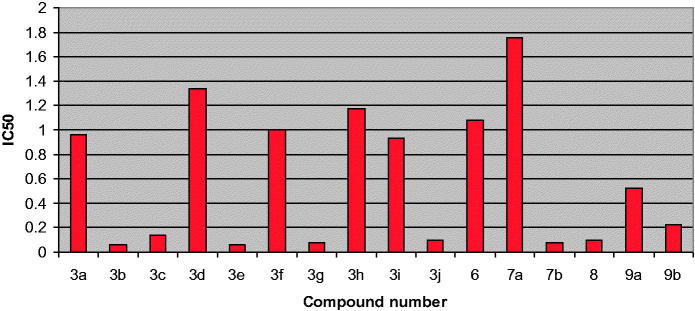
IC50 of the synthesised compounds in µM on pim-1 kinase.